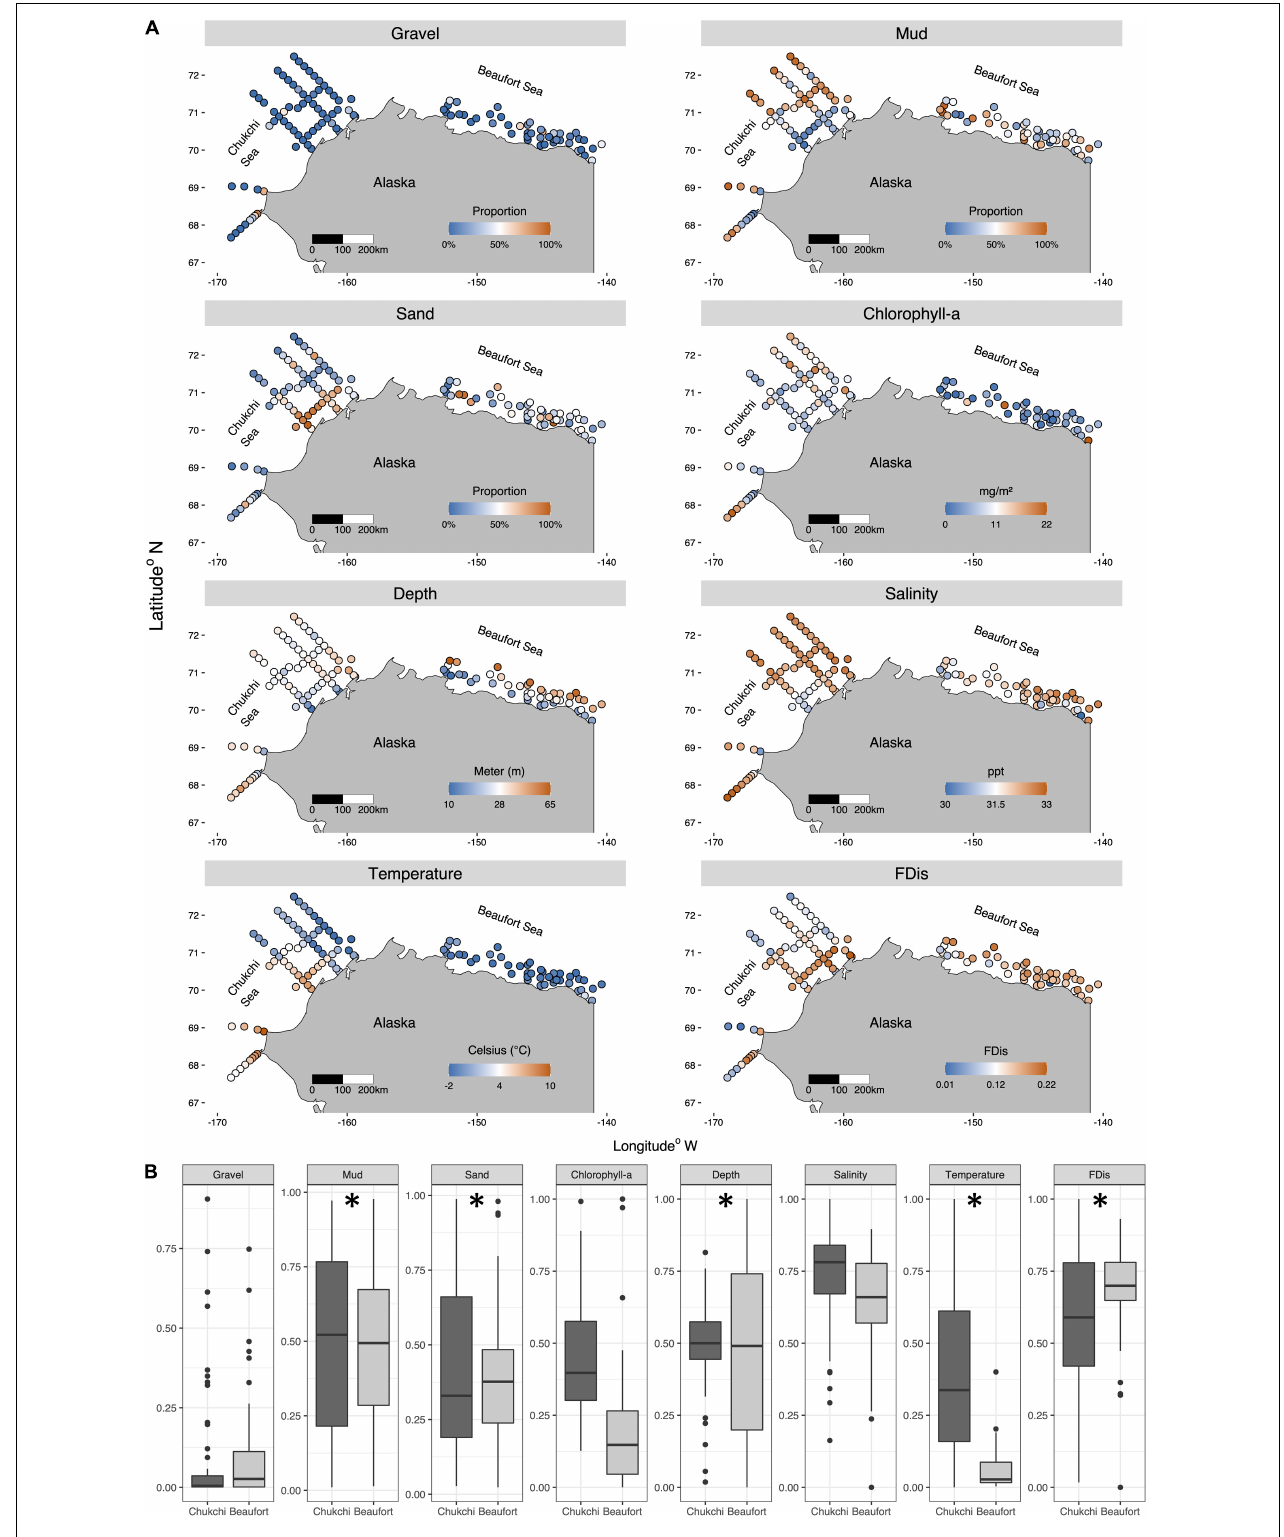
FIGURE 6 | Spatial representation of the Chukchi and Beaufort Sea environmental variables and of functional dispersion (FDis) (A) . Variance of environmental variables and FDis were compared between the Chukchi Sea (dark gray) and the Beaufort Sea (light gray) (B) . Horizontal lines: median, boxes: inter-quartile range (IQR); whiskers: highest/lowest values ≤ 1.5x IQR above/below box; black points: outliers; *: significance ( p < 0.05) of variance of environmental variables and FDis using Levene’s Tests.